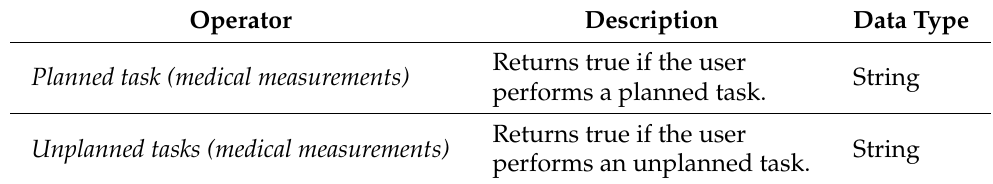
Table 13. Event-based